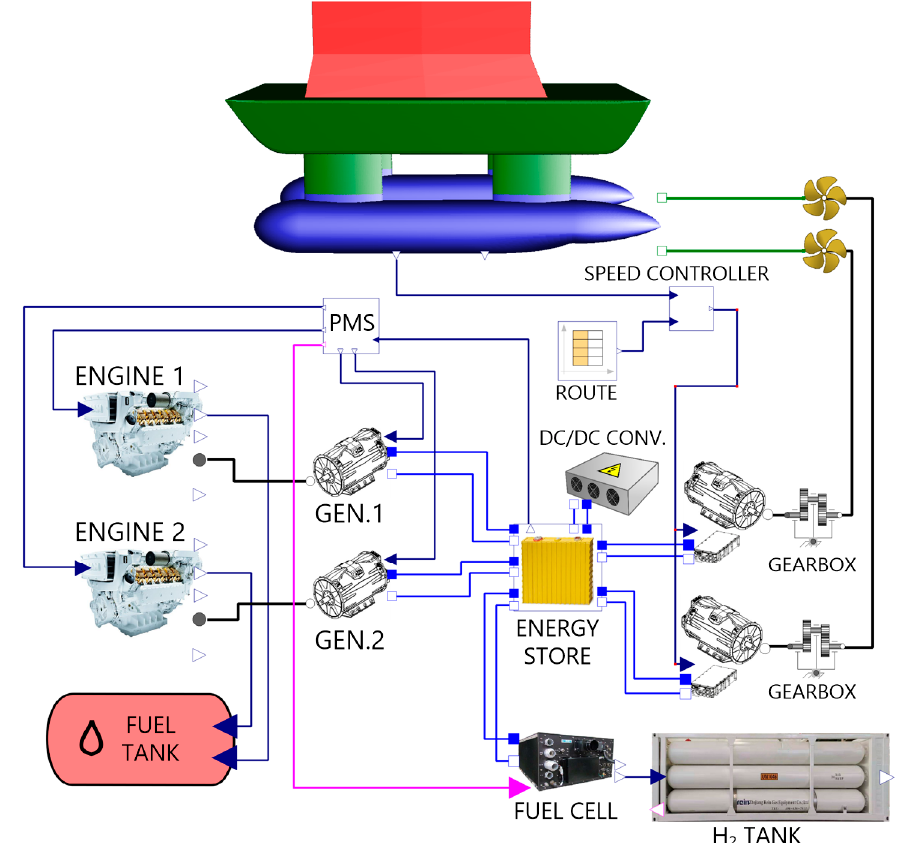
Figure 11. Model of a hybrid Diesel-Battery-Electric SWATH II powertrain developed in Modelica.